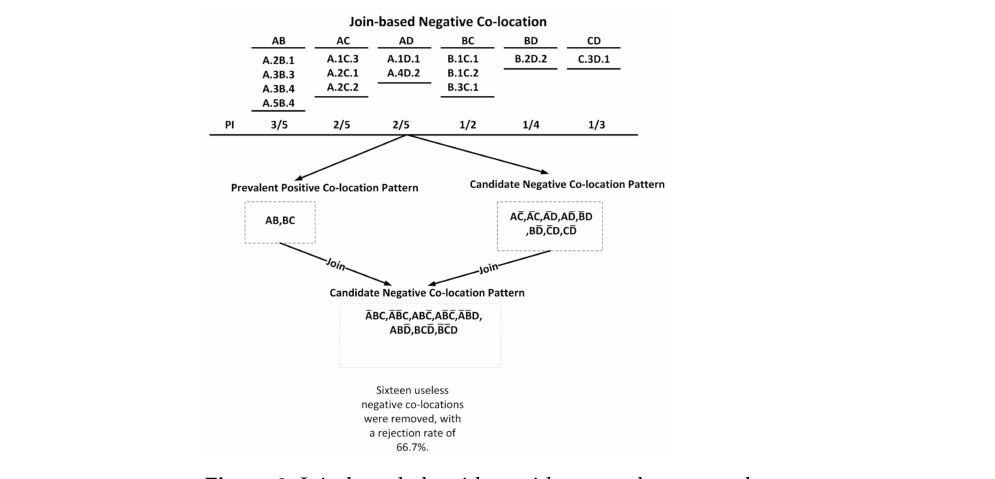
Figure 3. Join-based algorithm with a complete